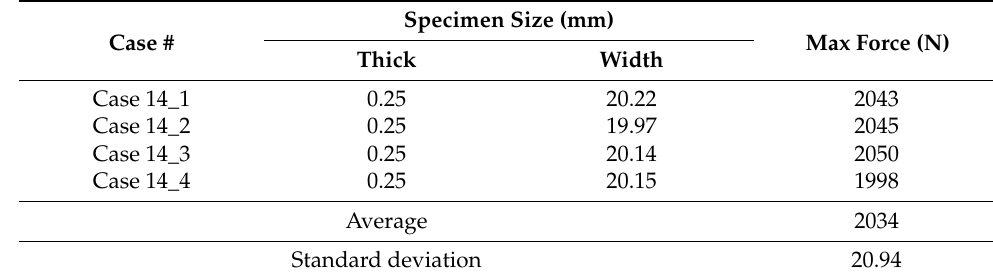
Table 7. Case 14 shear strength test result.